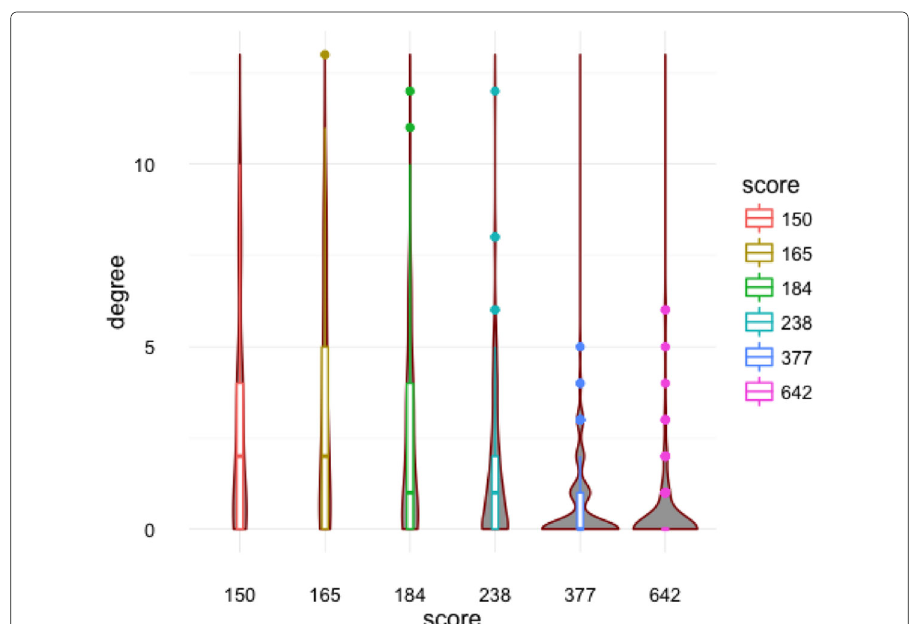
Fig. 16 Degree distribution of the private proteins networks according to the chosen percentile